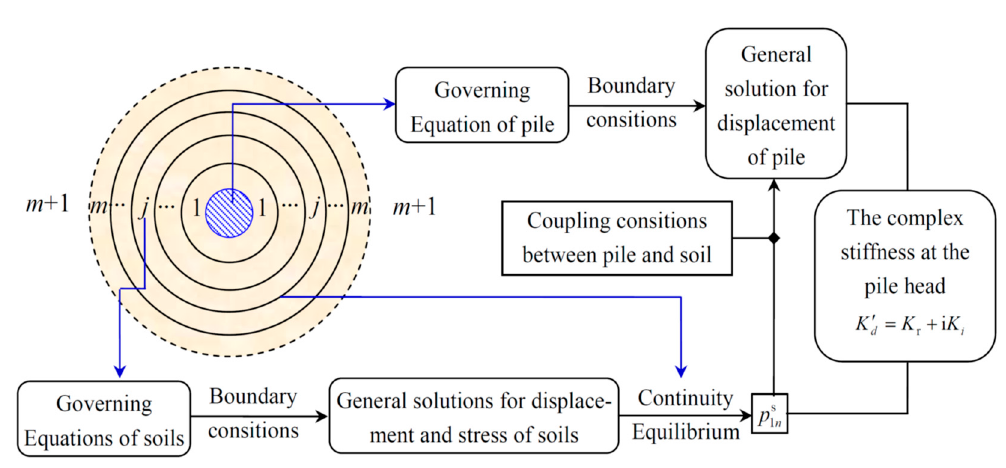
Figure 2. The derivation procedure of complex stiffness.